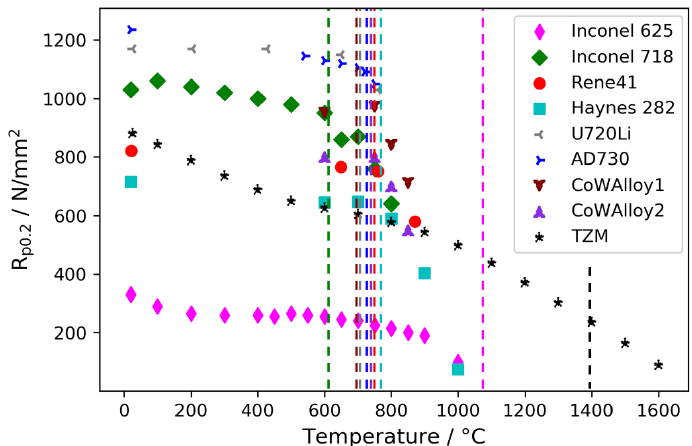
Figure 4. Yield strength of the different alloys as a function of temperature. The dashed lines represent the lowest temperature of the heat treatment.